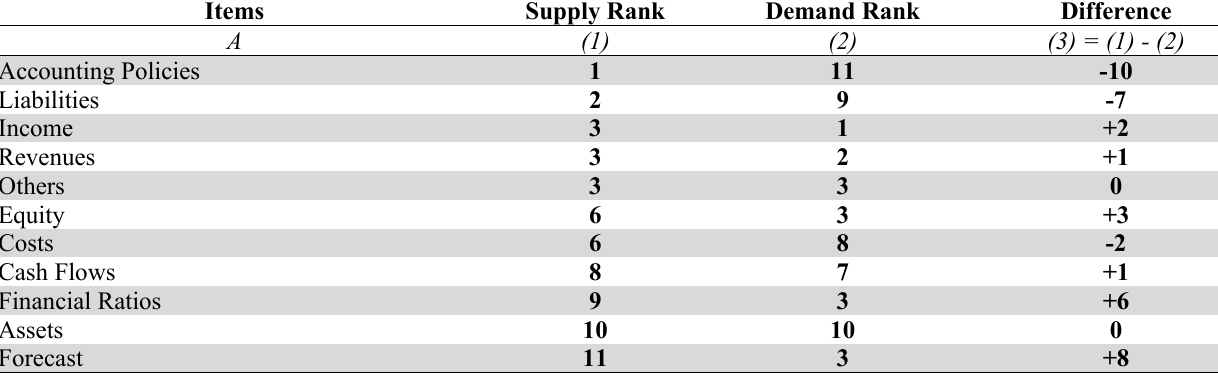
The comparison between the supply and demand information